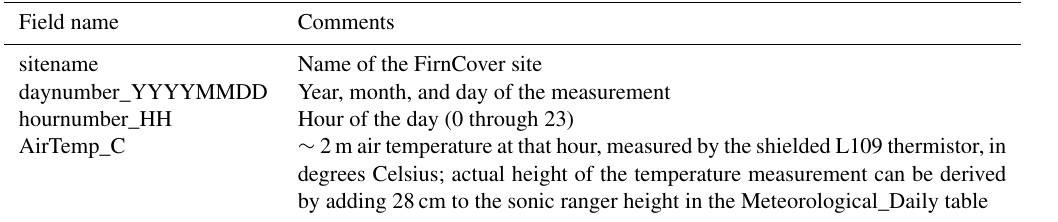
Table A2. Air_Temp_Hourly